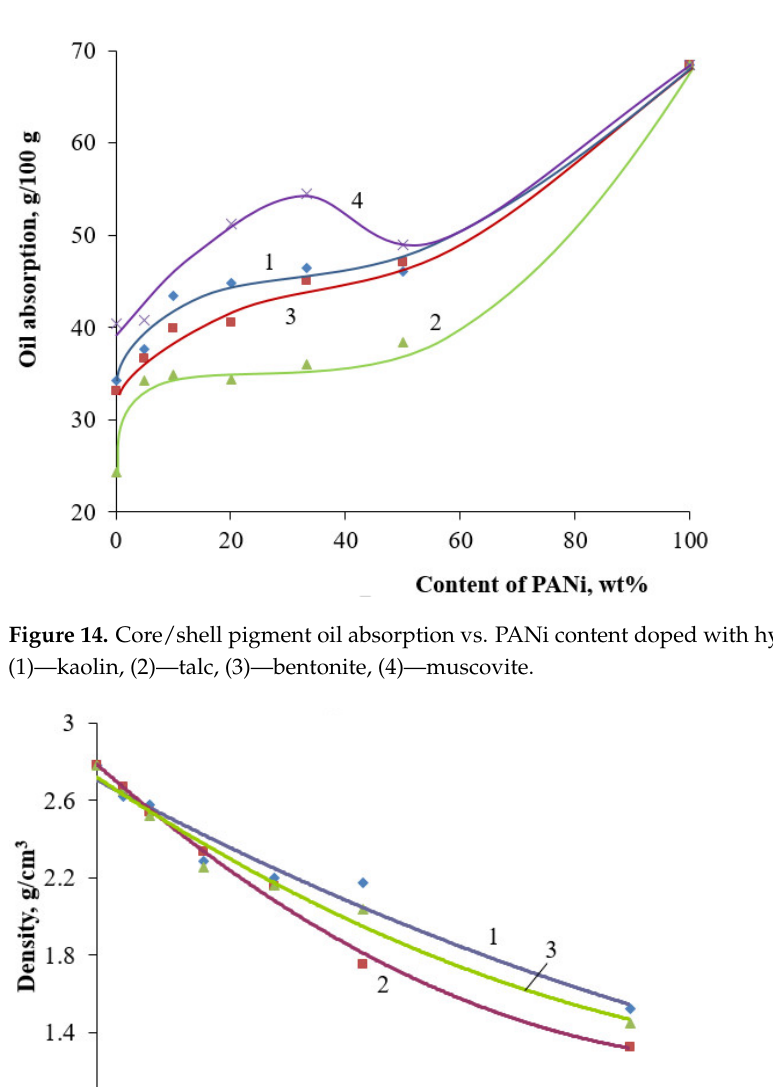
Figure 13. Dependence of oil absorption of core/shell pigments with a talcum core, from the content of PANi doped with various acids. Doping acid: (1)— Н 2 SO 4 ; (2)— НСl; (3)—H 3 PO 4 .